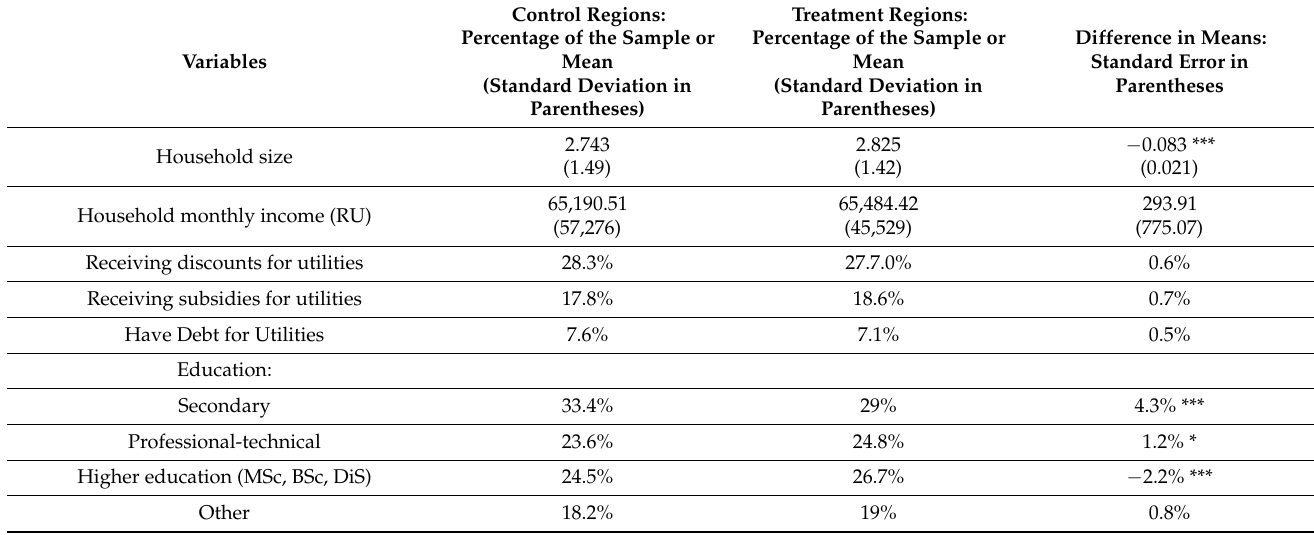
Table 3. Household’s